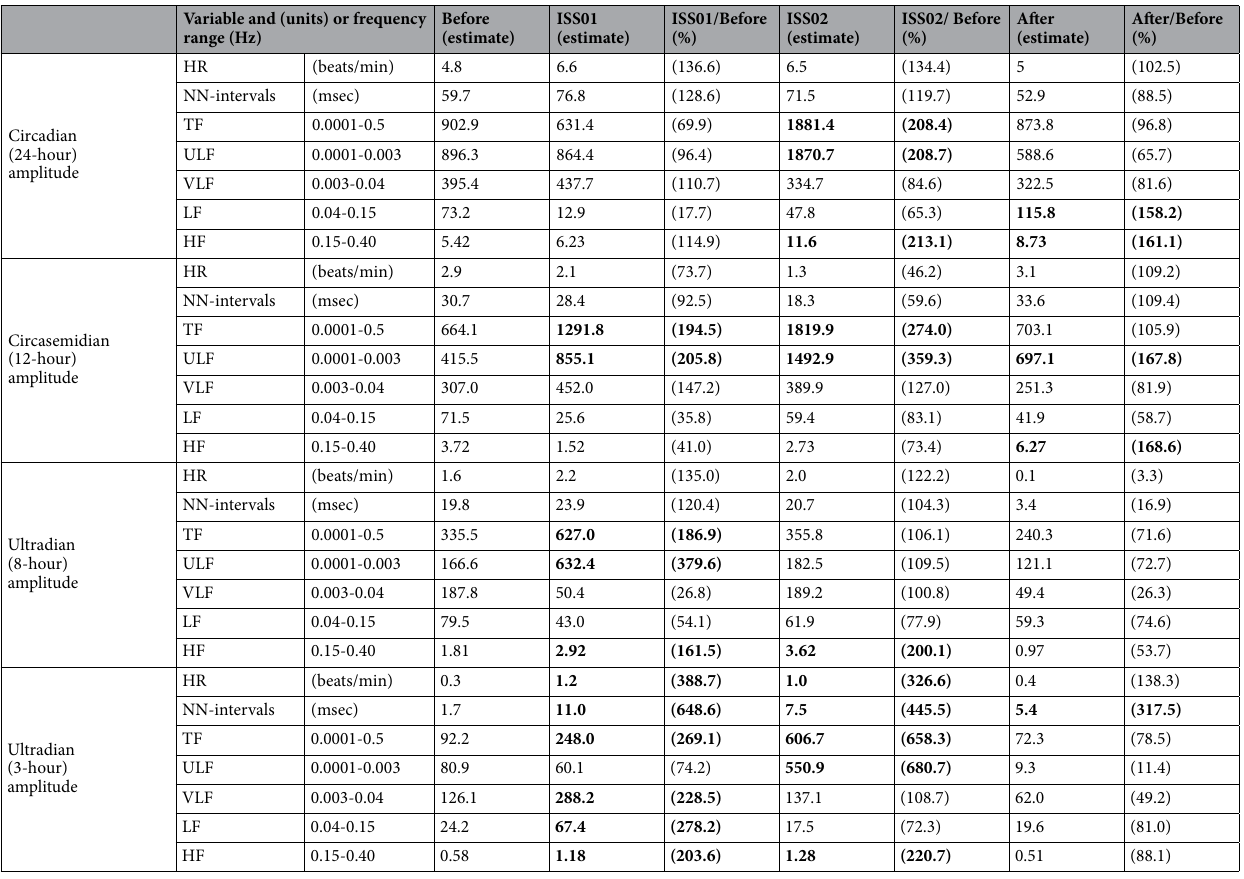
Table 2. Changes in amplitudes of heart rate and heart rate variability during 12-month spaceflight. Bold areas show increases by more than 150% compared to